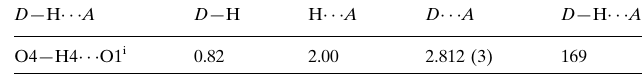
Hydrogen-bond geometry (A˚ , (cid:1)